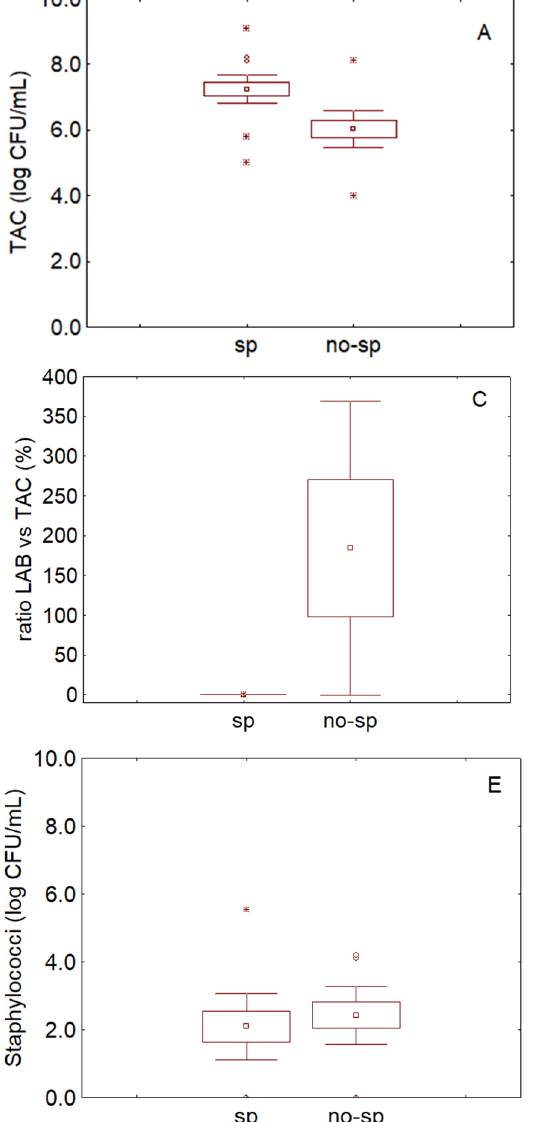
Figure 1. Total Aerobic Count (TAC) ( A ), Lactic Acid Bacteria (LAB) ( B ), ratio LAB vs. TAC ( C ), yeasts ( D ), and staphylococci in brines ( E ). sp, spoiled samples, no-sp, non-spoiled samples. ▫ Mean; Mean±SE; ◦ Outliers; * extremes; bars denote 95% confidence interval.